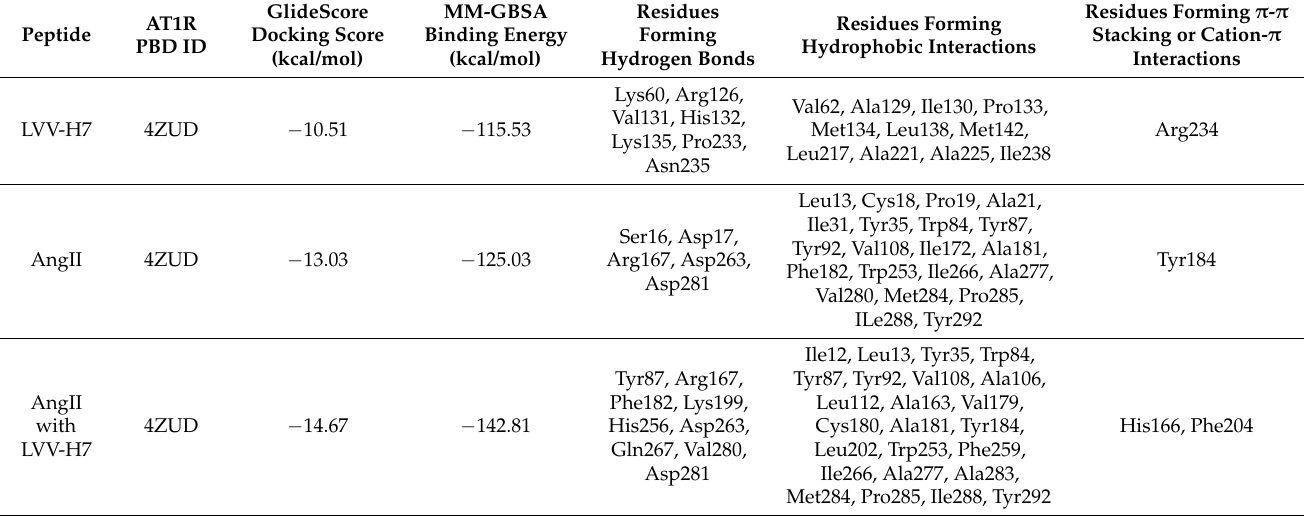
Table 1. AT1R residues that interacted with the best docked pose of LVV-H7 and